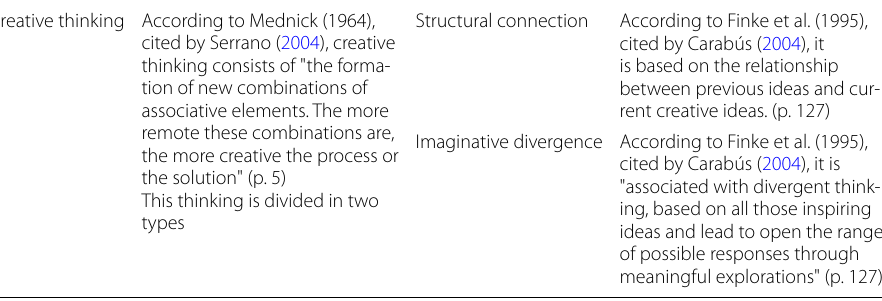
Table 2 Creative thinking. Multiple sources. Elaborated by Félix Socorro. May 2020 Creative thinking According to Mednick (1964), cited by Serrano (2004),